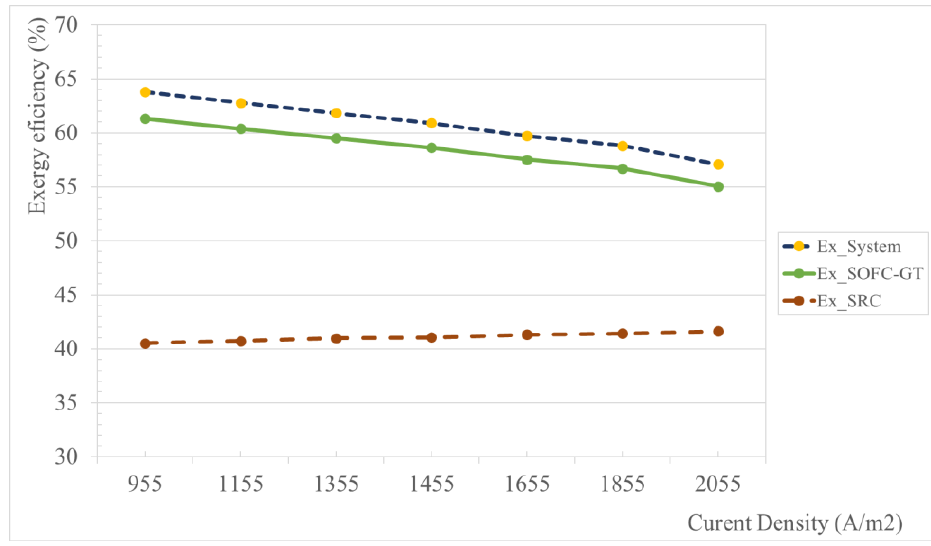
Figure 5. Effect of current density on the exergy efficiency of